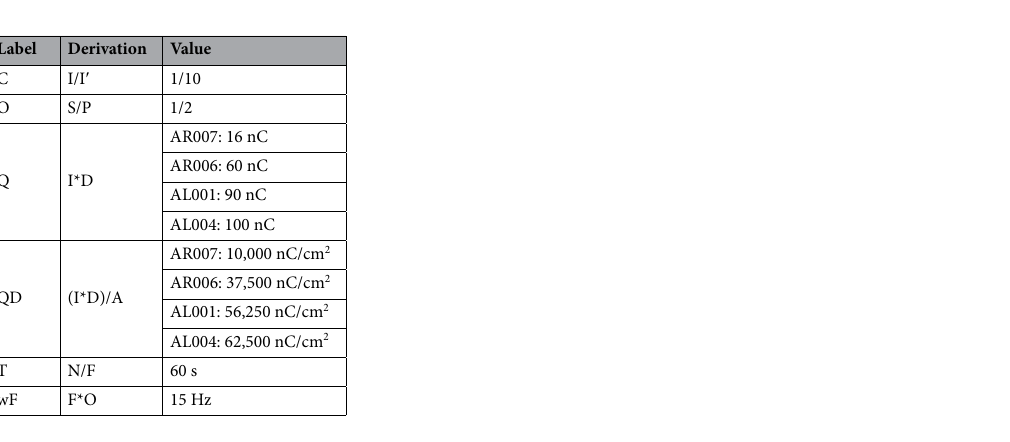
Table 3. Derived stimulation parameters. The different parameter describe the amplitude of stimulating and reversal phase ratio (C), the percentage of the effective stimulation time (O), the charge of the stimulating phase (Q), the charge of the stimulating phase per unit area (QD), the train duration (T), and the weighted frequency of effective stimulation